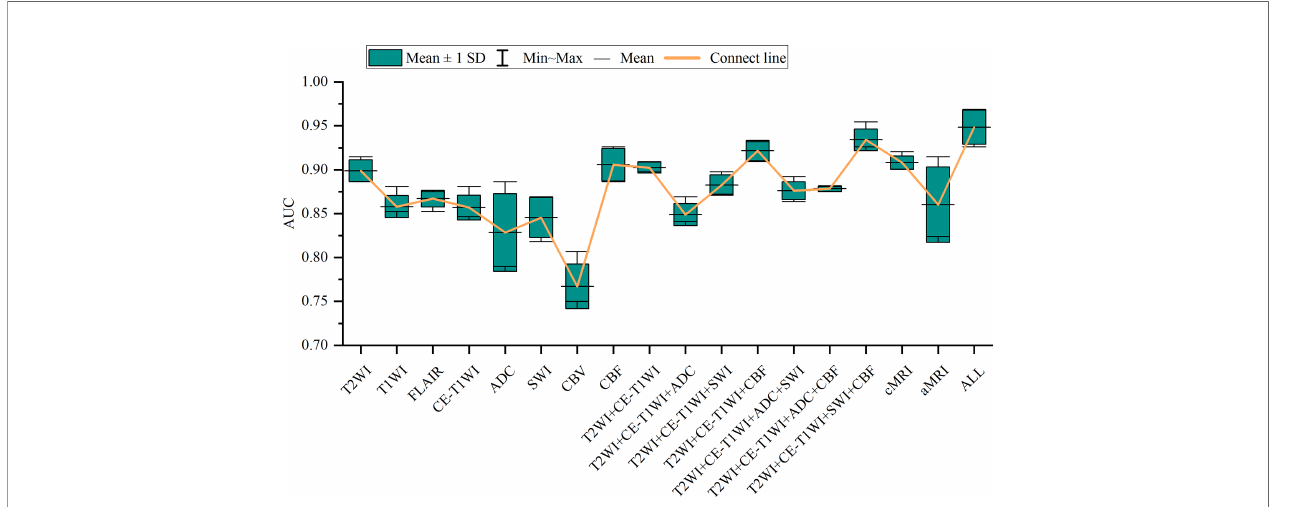
FIGURE 3 | Box-and-whisker plots illustrate the top- fi ve-performing area under the curve (AUC) values of different